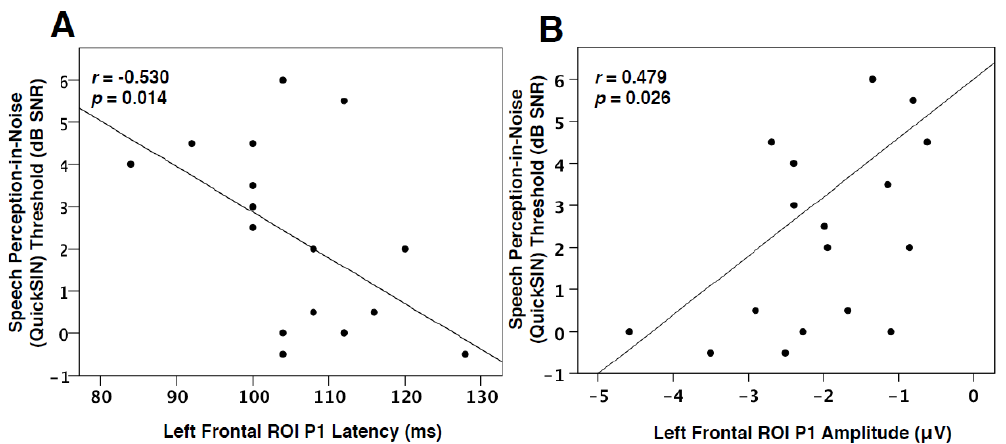
Figure 5. Quick SIN TM and VEP Frontal ROI Correlations. ( A ) The correlation of VEP P1 latency in the left frontal ROI as a function of QuickSIN ™ threshold values. P1 latency is shown on the horizontal axis in milliseconds and threshold values on the vertical axis as signal-to-noise ratio in dB (dB SNR). Note that a lower threshold indicates good auditory performance. The Spearman’s rank order correlation value and significance level are shown in the upper left corner. ( B ) The correlation of VEP P1 amplitude in the left frontal ROI as a function of QuickSIN ™ threshold values. P1 amplitude is shown on the horizontal axis in microvolts.